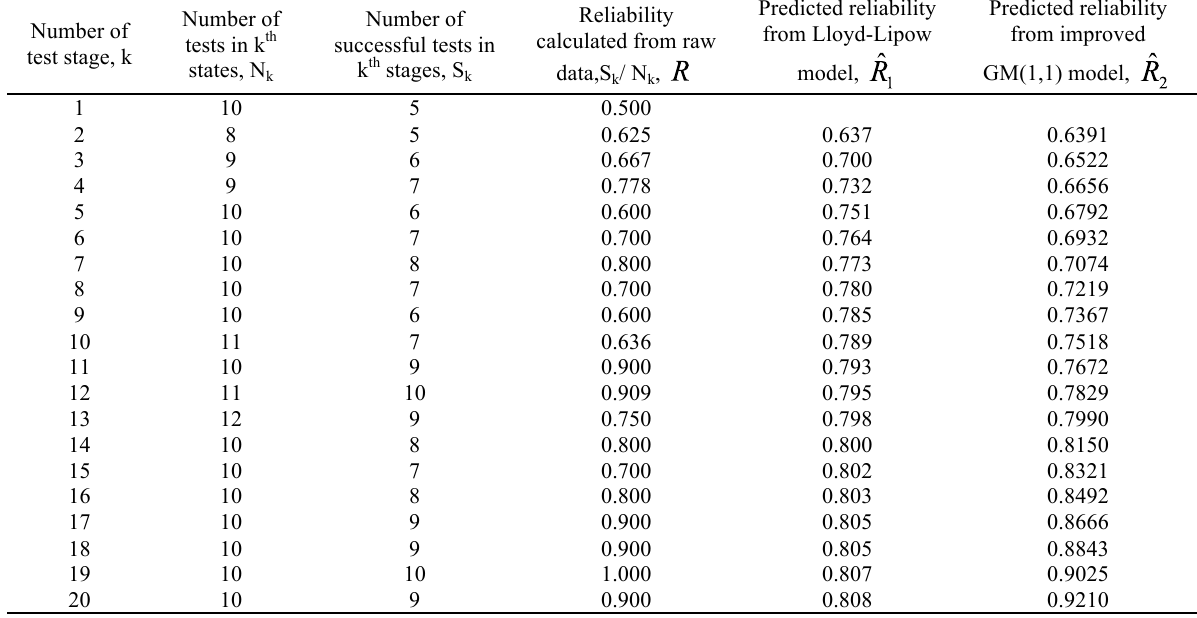
Table 1. Predicted reliability from the Lloyd-Lipow model and the improved GM(1,1)